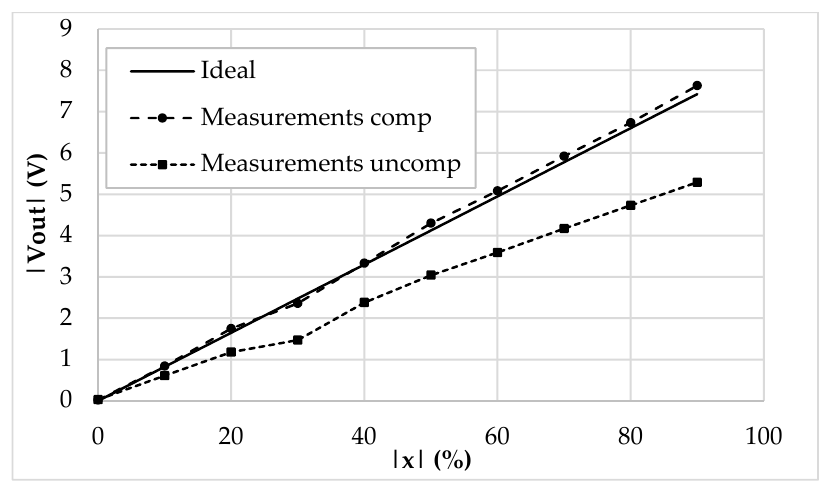
Figure 12. DC characteristic ( |V out | vs |x |) of the prototyped interface.